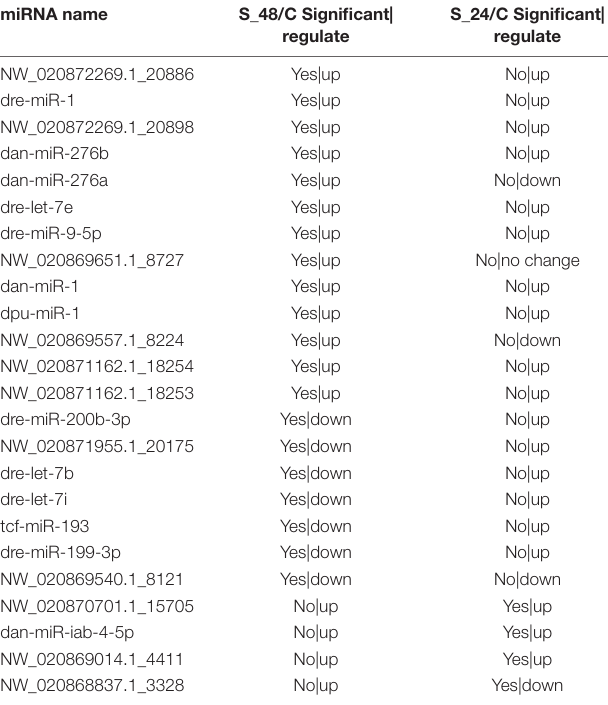
TABLE 1 | The detail of differentially expressed